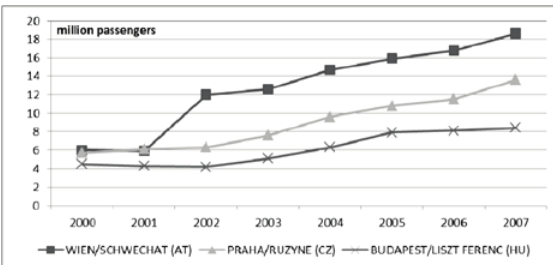
fig. 11. Different development paths in the Central European region (Source: own edition based on Hungaro Control Data) If in January 2012 only 100,000 transit